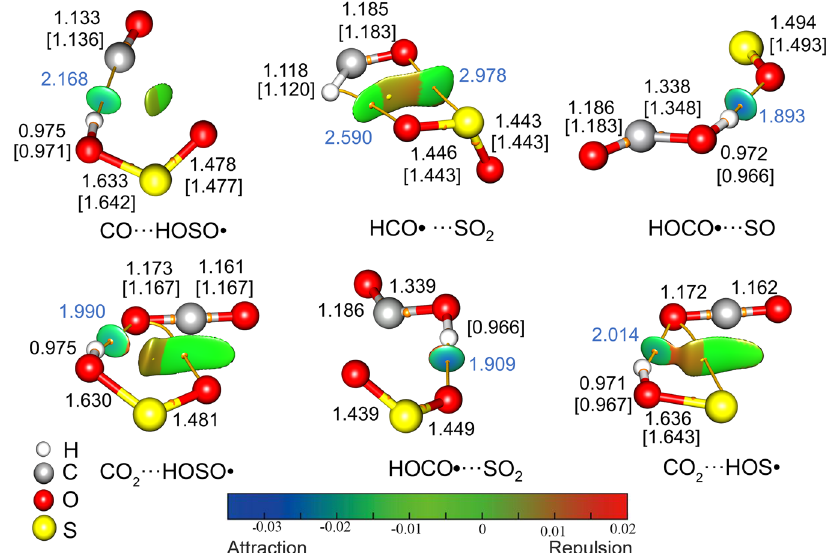
Fig. 6 | The CCSD(T)/aug-cc-pV(T+D)Z calculated molecular structures and noncovalent interaction analysis for all the observed complexes. The bond lengths (Å) for the monomers are given in square brackets, and the lengths for the intermolecular hydrogen bonds are shown in blue. The calculated gradient